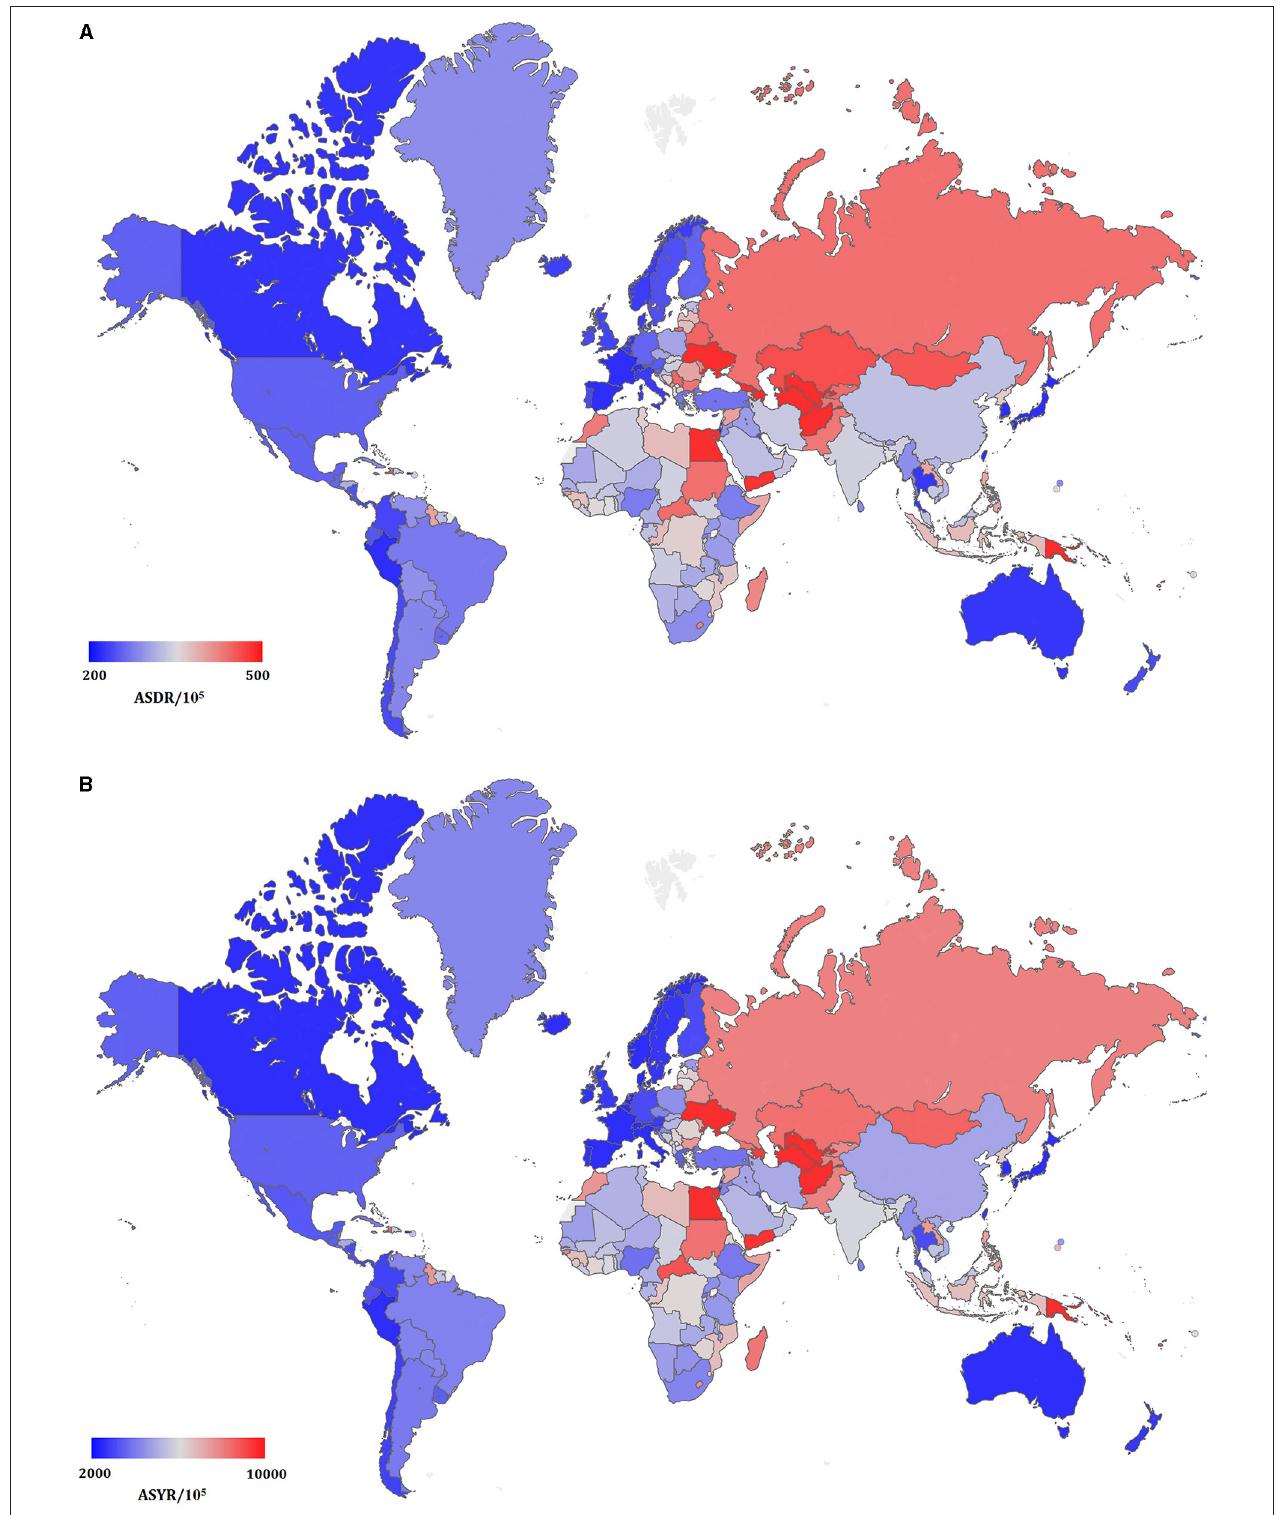
FIGURE 5 | The global disease burden of cardiovascular disease in 195 countries and territories. (A) The ASDR of cardiovascular disease in 2017; (B) the ASYR of cardiovascular disease in 2017.